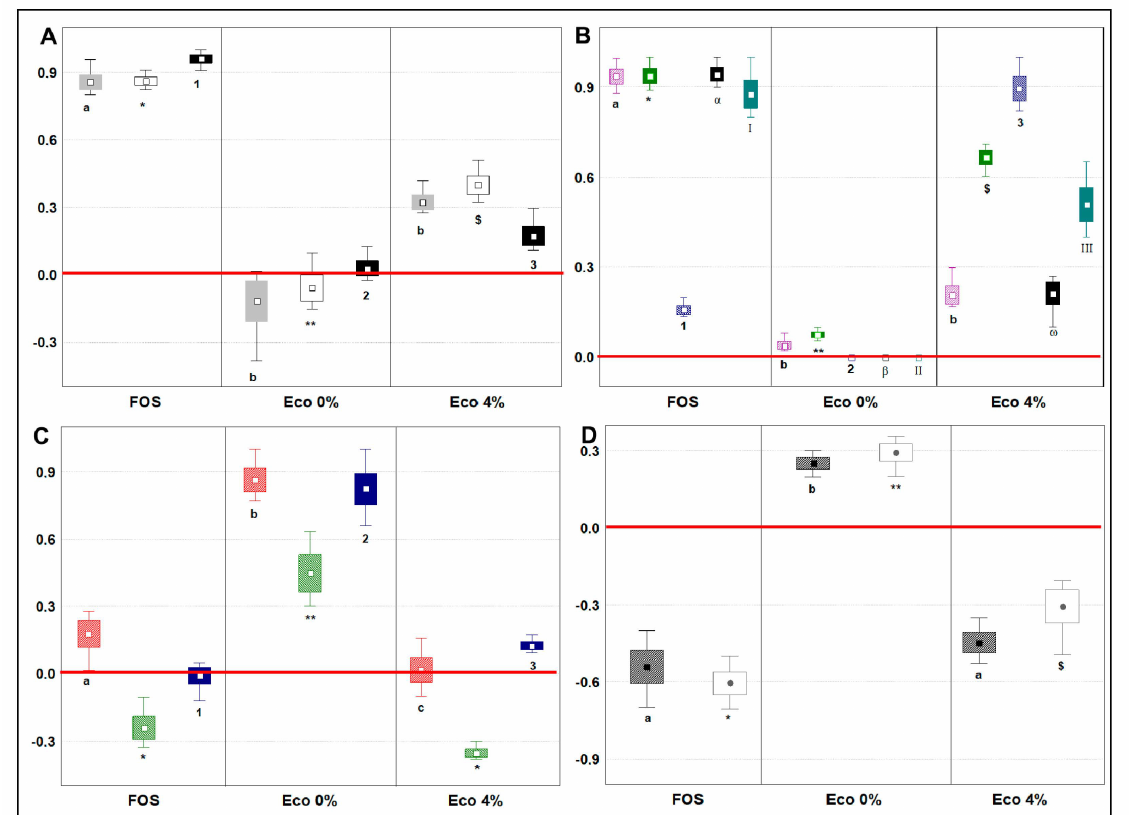
Figure 3. Endpoint changes in main microbial metabolites related to prebiotic activity, expressed as normalized scale from relative abundances with respect to the baseline (red line). The baseline absolute quantifications in mg/Kg are found in the Supplementary Material (Table S2). Changes were recorded after 24 h of in vitro batch colonic fermentations inoculated with human feces (n = 3 healthy donors) and administrated with FOS, Eco 0%, and Eco 4%. Samples were analyzed in duplicate from two independent experiments ( n = 4). Box = mean; Rectangles = mean * S.D.; Whiskers = min and max values. Cases with different letters or numbers or symbols among a single independent variable are significantly different according to Tukey’s HSD test ( p < 0.05). ( A ) Short-Chain Fatty Acids: gray plot = Acetic acid; white plot = Propanoic acid; black plot = Butanoic acid. ( B ) Medium-Chain fatty Acids: Fuchsia plot = Hexanoic acid; green plot = Heptanoic acid; blue stripes plot = Octanoic acid; black plot = Nonanoic; pale blue plot = n-Decanoic acid. ( C ) Branched-Chain Fatty Acids: red plot = Propanoic, 3-metyl acid; green plot = Butanoic, 3-methyl acid; blue plot = Pentanoic, 2-methyl acid. ( D ) Indoles: gray plot = Indole; white plot =